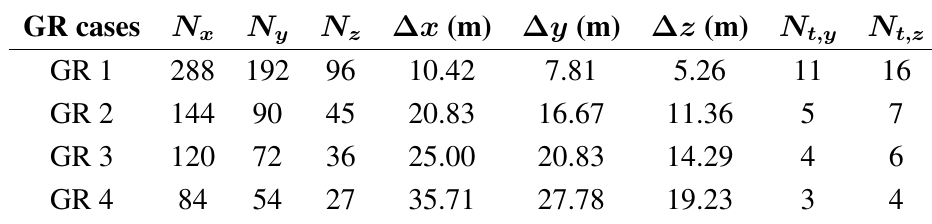
Numerical set-up for neutrally-stratified ABL simulations with different grid resolutions